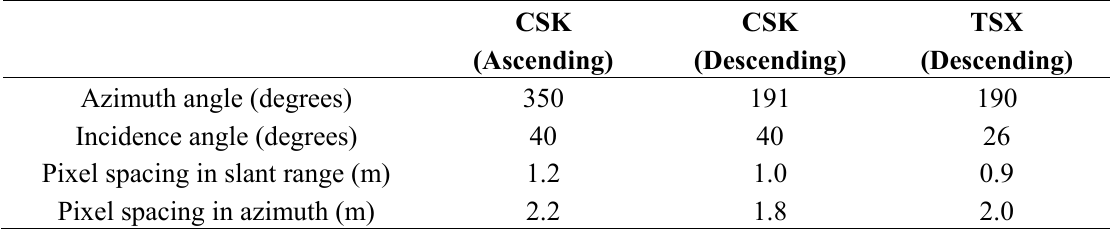
Figure 2. The study area around Shanghai and the coverage of the three types of SAR images. The insert depicts the location of Shanghai in China. The red, yellow, and blue rectangles indicate the ascending CSK, descending CSK, and descending TSX coverage, respectively. The dashed black rectangle indicates the study area, i.e. , the overlapping area of the three types of SAR images. The filled white triangle denotes the ITRF2000 reference station SHAO. Table 1. The parameters related to the ascending/descending CSK and descending TSX SAR